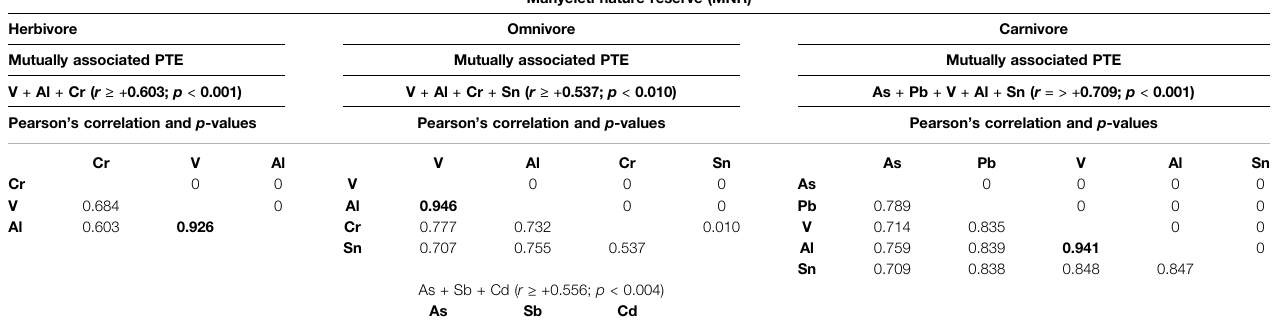
TABLE3| MutuallyassociatedPTEsandotherPTEcorrelationsattheManyeletiNatureReserve(MNR)indifferenttrophicgroups.Greyhighlightedblockswithboldlettering showhighestmutuallyassociatedPTEforrespectivetrophicgroups.BoldtextrepresentsthehighestmutuallycorrelatedelementsandothercorrelatedPTEsforspeci fi c trophic groups. Faecal concentrations are given as microgram per kilogram (µg/kg) faecal dry mass (DM). Tswalu Kalahari Reserve (TKR) other PTE correlations" Herbivores - "Ba + Sr: r = + 0.699 ; p < 0.001 . Manyeleti nature reserve (MNR) Herbivore Omnivore